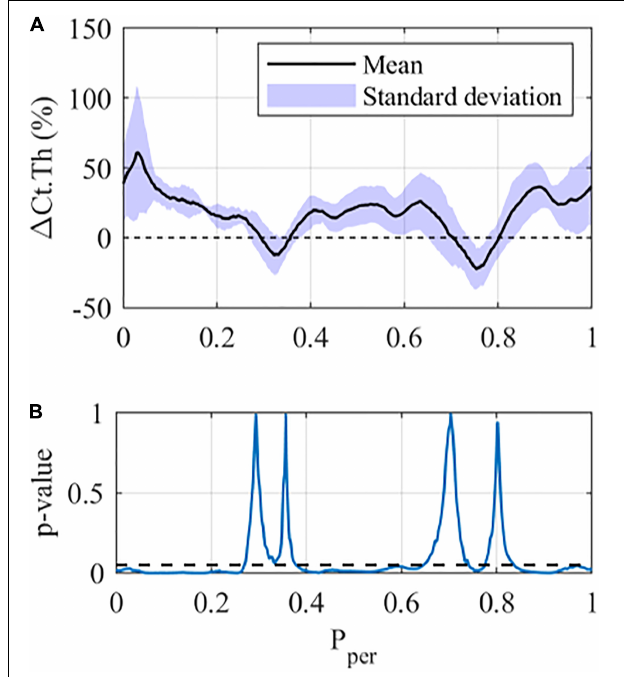
FIGURE 2 | Local cortical thickness variation for the 12 N loading case at the middle tibial region (z = 50%): (A) Mean (black line) and standard deviation (Shaded area) along the periosteum (cid:49) Ct.Th ± SD vs P per and (B) p -value using a student-paired t -test at each periosteal position (statistical significance indicated by values below the dashed line, i.e., p <